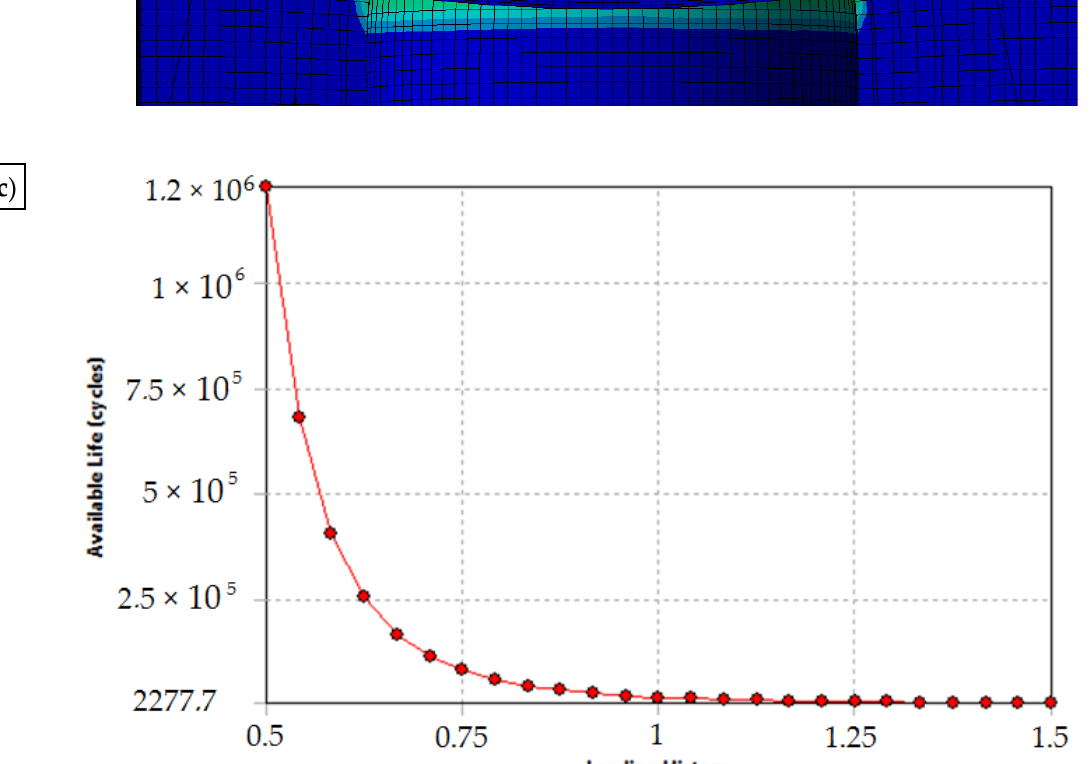
Figure 13. Results of the simulation of the punching process with the use of a sharp punch (without rounding of the cutting edge—r = 0: ( a ) state of pressure in the contact zone [MPa]; ( b ) durability; ( c ) fatigue sensitivity.